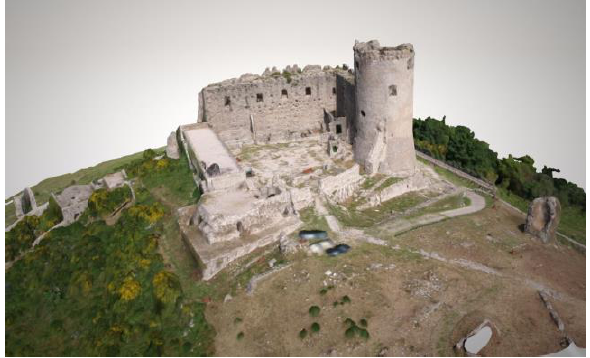
Figure 9: 3D mesh of the donjon.